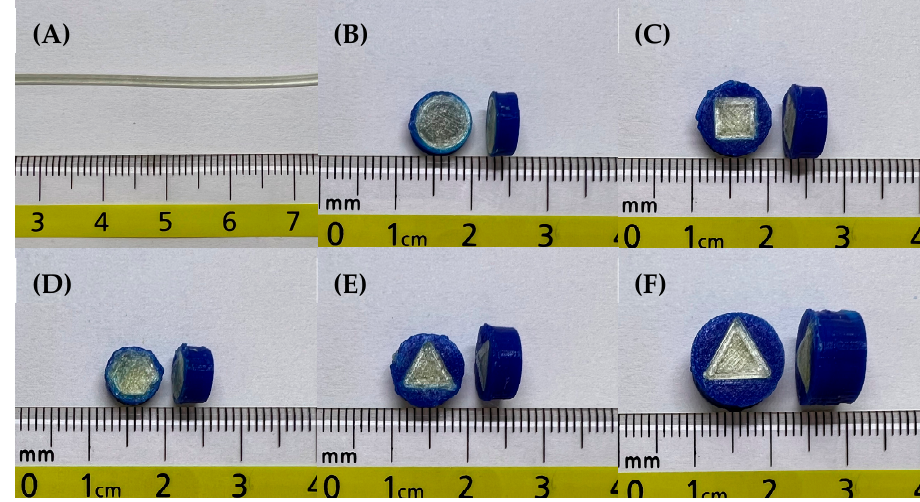
Figure 2. The photo images of ( A ) the FDP-loaded PVA filament, FDP-loaded 3D-printed tablets with different internal surface geometries, that is, ( B ) round, ( C ) square, ( D ) hexagon, and ( E ) triangle, and ( F ) FDP-loaded 3D-printed tablet with triangle surface geometry and double the volume of the inner compartment.